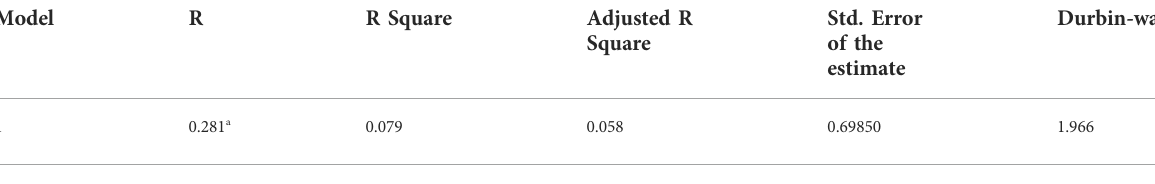
TABLE 4 Summary model corresponding to the dependent variable for Pic.